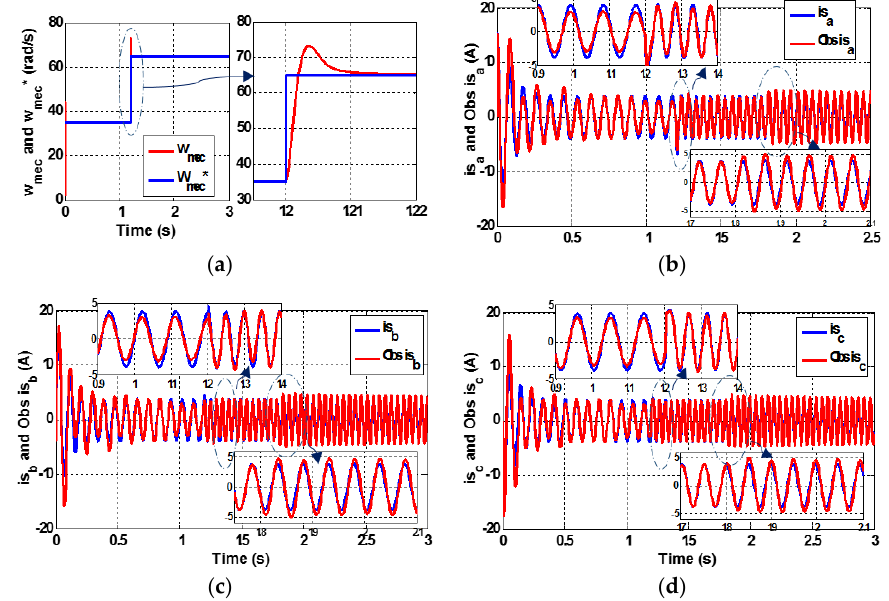
Figure 11. Performance of the system using the proposed FTC approach under sudden wind speed variation at t = 1.2 s and then under 33% increase in both stator and rotor resistance values at t = 1.8 s: ( a ) mechanical speed ω mec and its reference ω mec * ( b ) measured and SMO-estimated stator current i sa ; ( c ) measured and SMO-estimated stator current i sb ; and ( d ) measured and SMO-estimated stator current i sc .